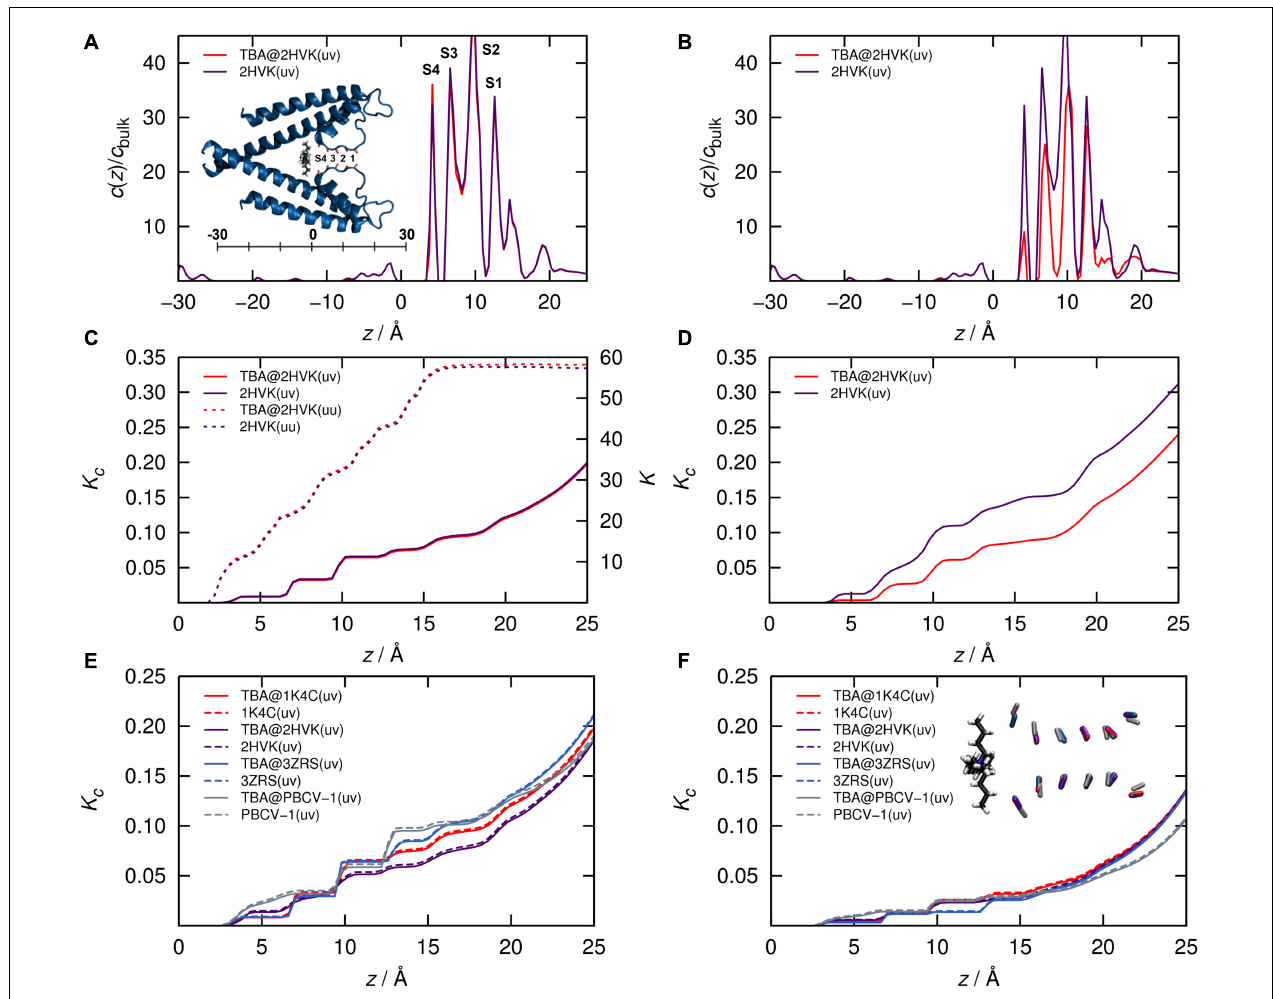
FIGURE 4 | (A,B) K + ion concentration profiles and (C,D) cumulative equilibrium constants as function of channel length coordinate z starting from the origin as shown in the inset in (A) from finite concentration (1 M, uv , solid lines) and infinite dilution (single hydrated ion, uu , dashed lines) 3D RISM calculations of KcsA (pdb code 2HVK) with (red) and without (purple) TBA placed in the cavity. (E,F) cumulative results for four reduced models with and without TBA comprising isolated carbonyl cages for KcsA (2HVK, Yohannan et al., 2007, crystalized with TBA and 1K4C (Zhou et al., 2001) crystalized without TBA), KirBac3.1 (3ZRS, Bavro et al., 2012) and the computationally determined filter model of Kcv PBCV − 1 (Tayefeh et al., 2009; Hoffgaard et al., 2015). (A,C,E) from calculations with original force field, (B,D,F) with down-scaled filter carbonyl charges leading to halved local dipole moments. The inset in panel (A) represents the full 2HVK system in cartoon representation. The inset in panel (F) shows a superposition of all reduced filter carbonyl groups in the same color code as the